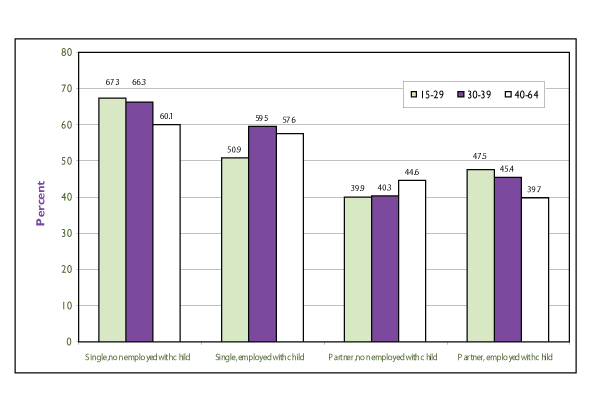
Percent Reporting High Chronic Stress by Multiple Roles and Age, Canada, NPHS, 1994–1995